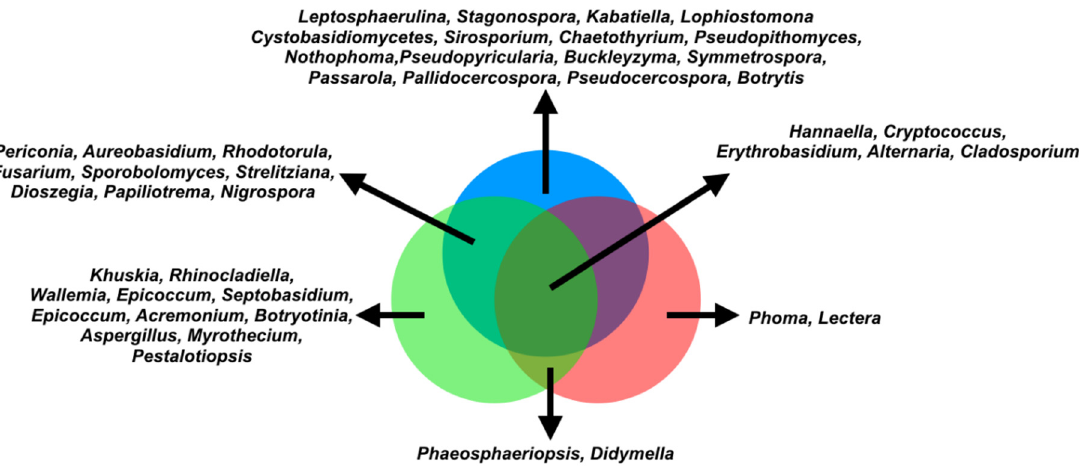
Figure 2. Venn diagram with differential distribution of genera. C. stenophylla (blue circle), C. racemosa (green circle), and C. arabica (red circle). Each arrow represents specific fungi for each coffee species. The central area represents the core mycobiome, fungi found in all three species. C. racemosa and C. stenophylla showed the highest number of species-specific fungi with 13 genera for C. racemosa and 17 genera for C. stenophylla , while C. arabica had only 2 specific genera: Phoma and Lectera . Only nine genera were present in C. stenophylla and C. racemosa , and only two genera were present in C. racemosa and C. arabica (Figure 2). No fungal genera were present in C. stenophylla and C. arabica (Figure 2).